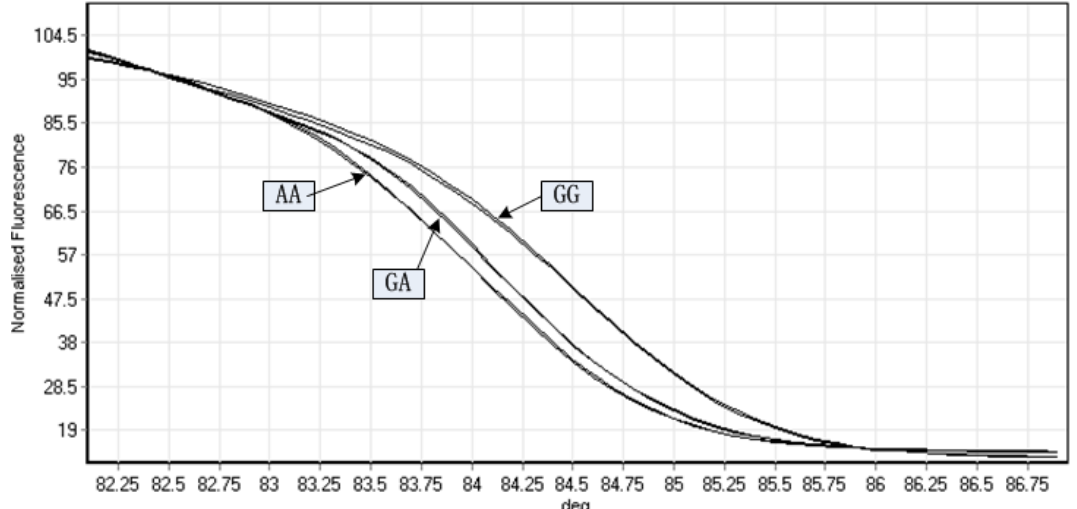
Figure 2. Different graphs produced with high resolution melting analyses of amplified fragments of the three different TBC1D1 c.214G>A SNP